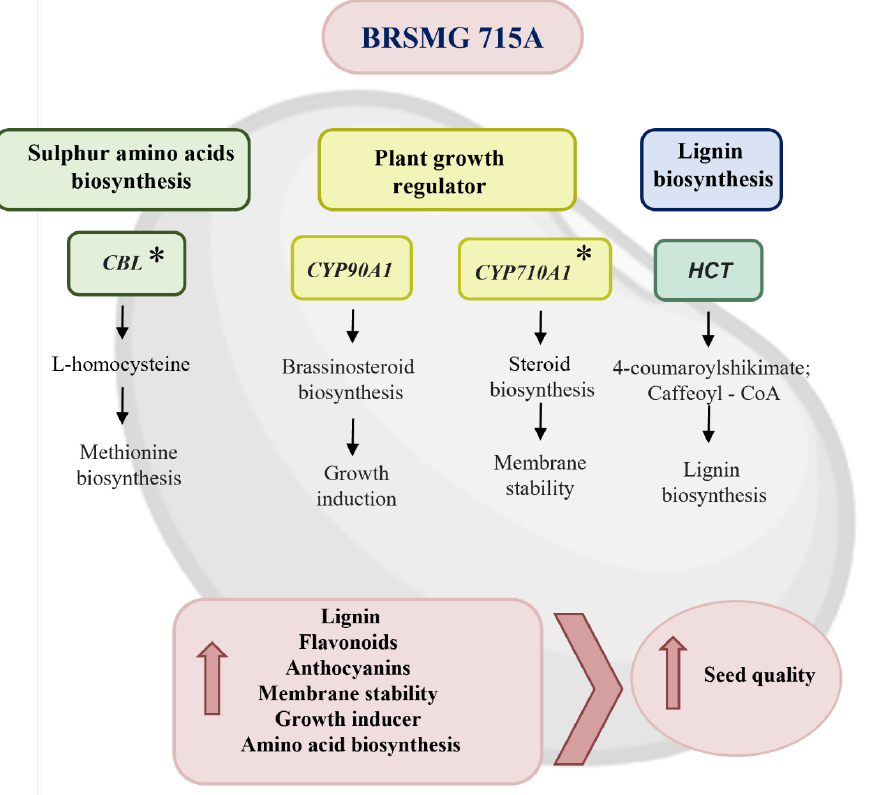
Figure 6. Schematic of the genes significantly induced in the black seed coat cultivar BRSMG 715A of soybeans with black seed coats in relation to the yellow seed coat cultivars BRS 413 RR and DM 6563 IPRO with their respective contributions to increase seed quality and longevity. (*) Asterisks indicate that the gene was induced in comparison to both yellow cultivars.